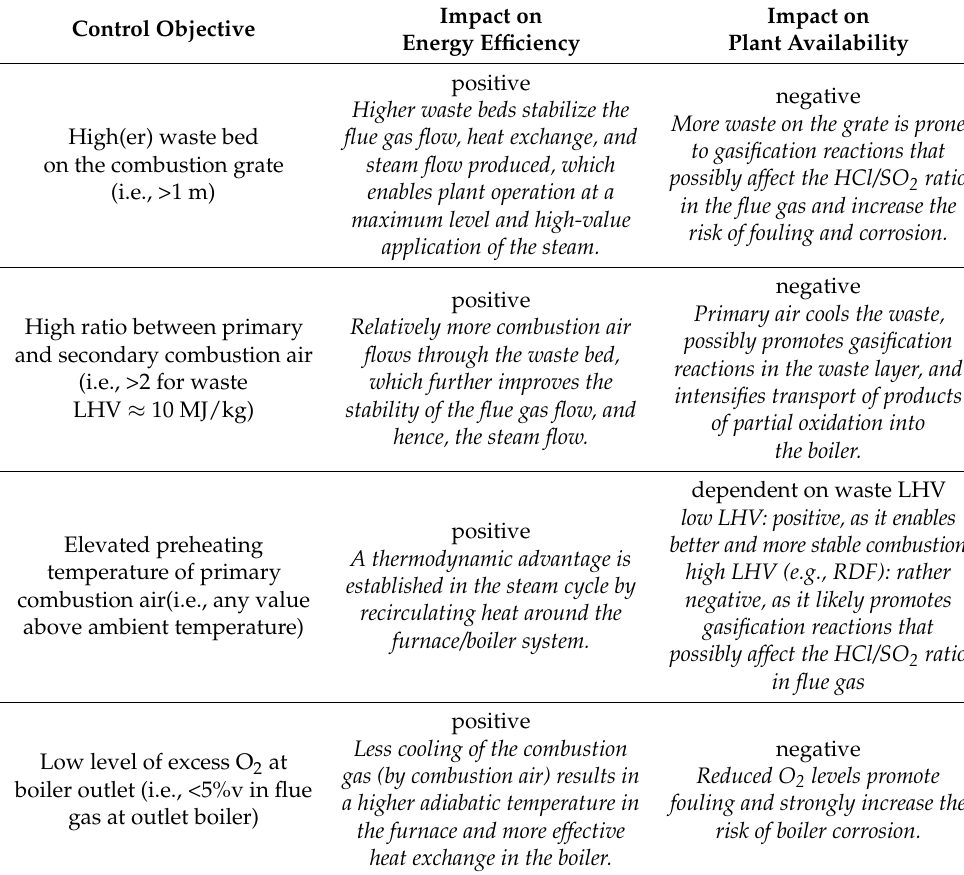
Table 1. Impact of combustion control on energy efficiency and plant availability for a moving-grate WtE combustion